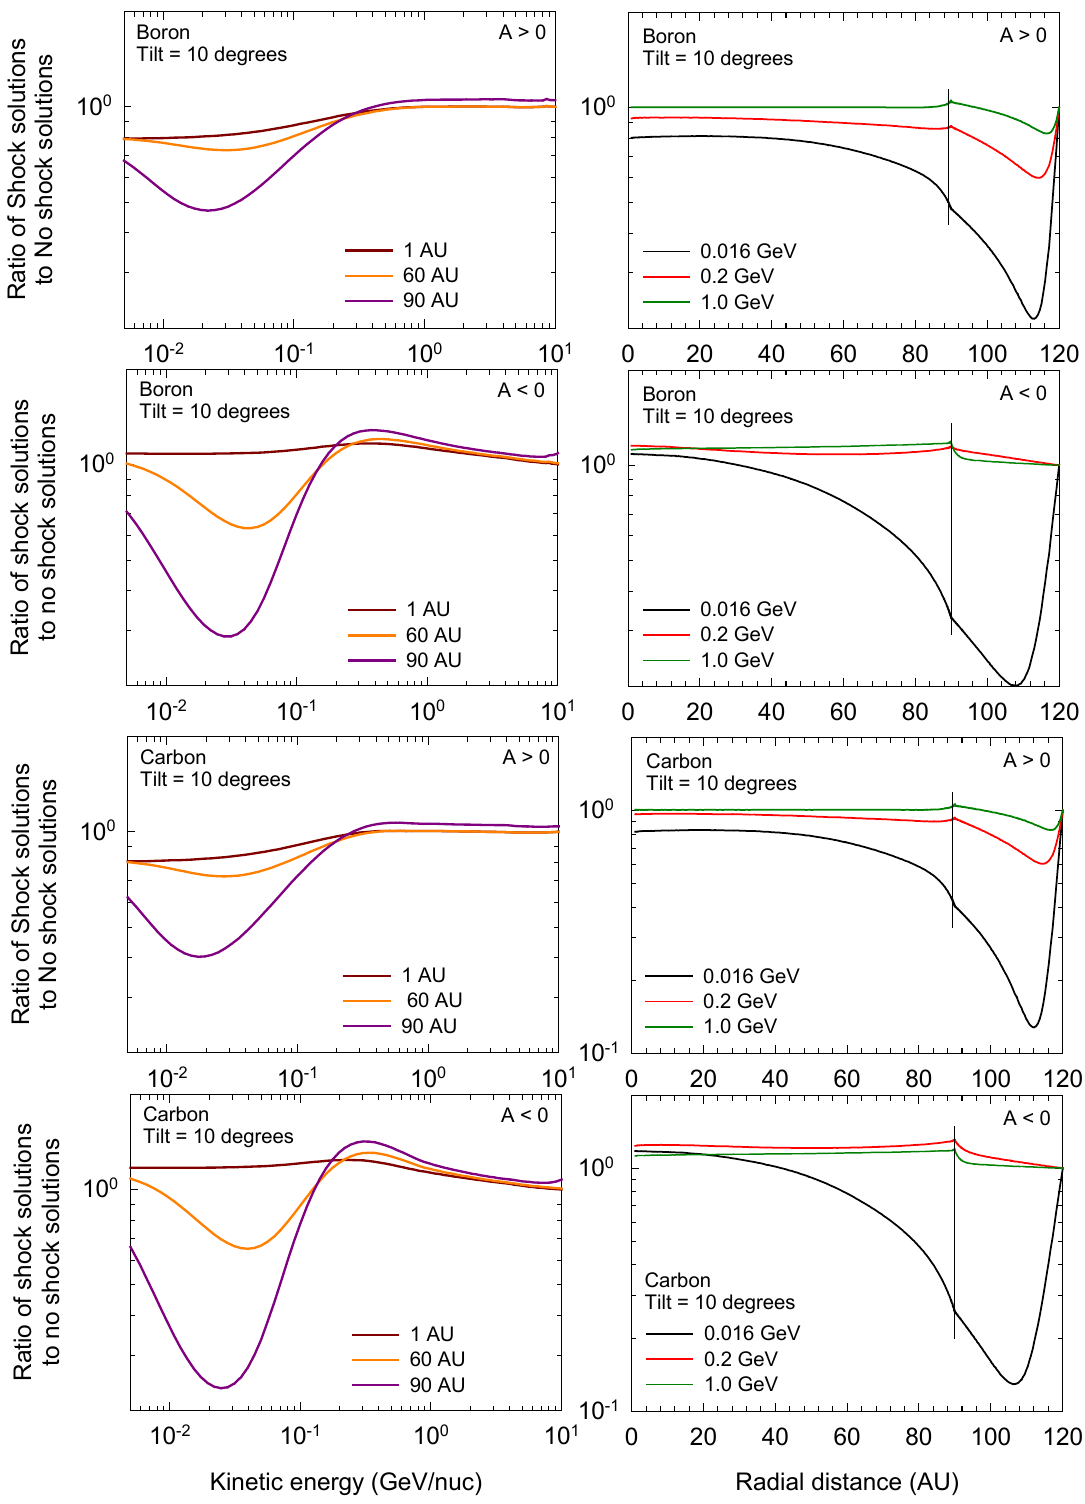
Fig. 3. Intensity ratios of solutions for B (top) and C (bottom) with a TS model compared to those without a TS in the model as a function of kinetic energy at radial distances of 1, 60, and 90 AU (left panels) and as a function of radial distance at energies of 0.016, 0.2 and 1.0 GeV (right panels) for both polarity cycles in the equatorial plane, with α = 10 ° .